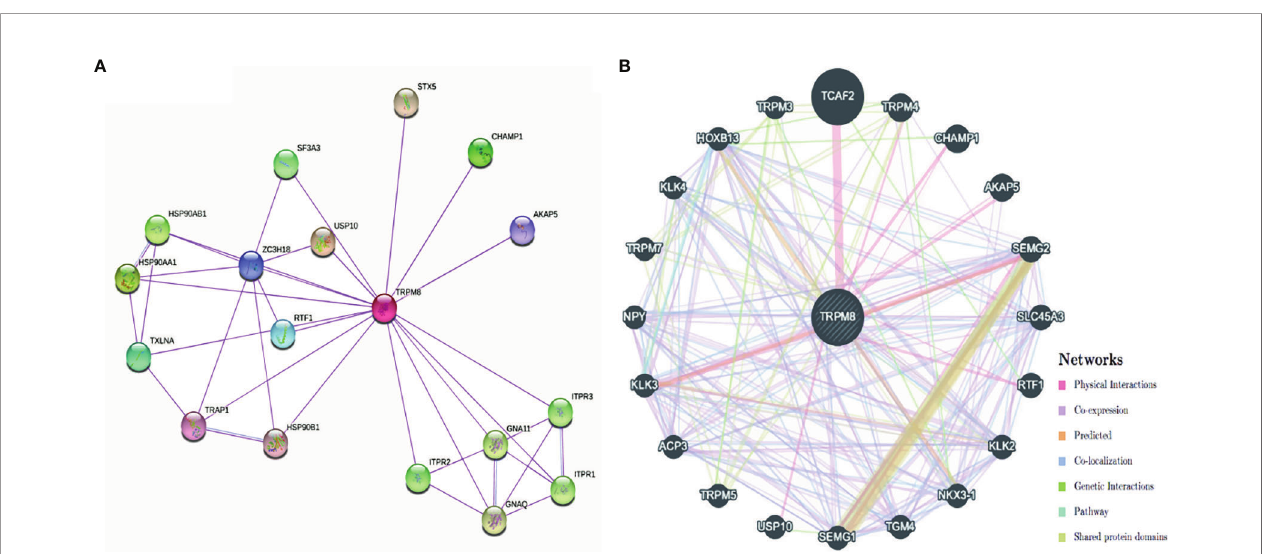
FIGURE 11 | PPI networks of TRPM8 and its interacting protein partners. (A) Network constructed by STRING. (B) Network constructed by